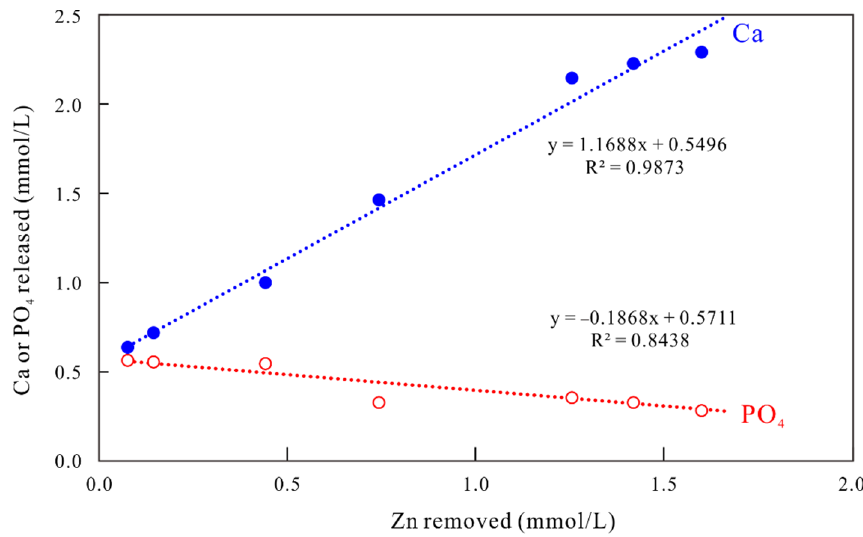
Figure 14. Relationship between the Cu (II) removed from solution onto solid and the Ca and P released from solid into solution.